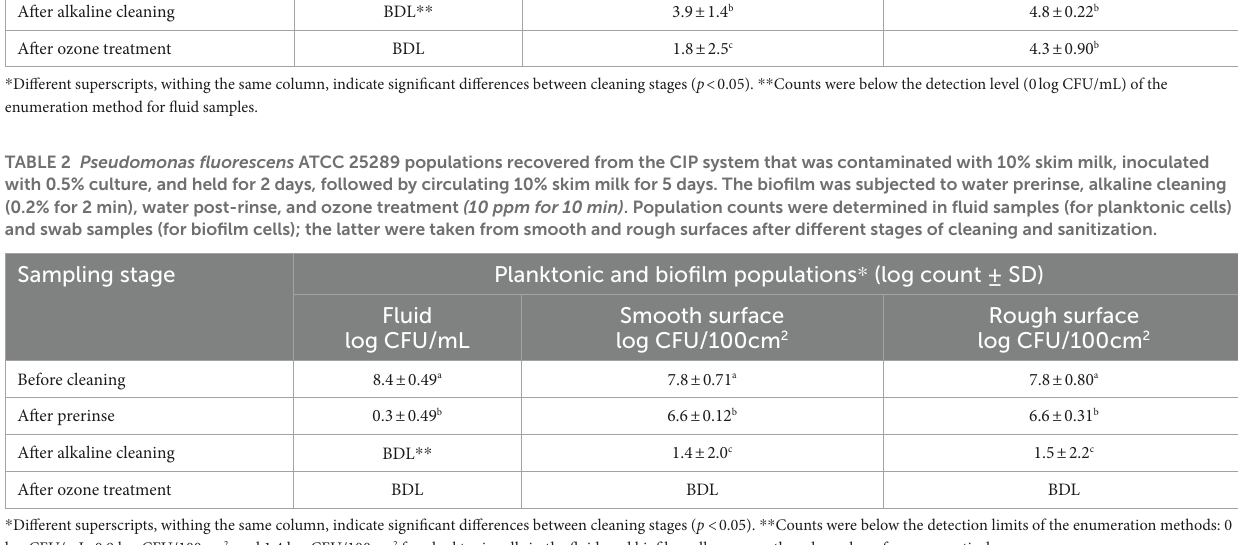
* Different superscripts, withing the same column, indicate significant differences between cleaning stages ( p < 0.05). ** Counts were below the detection limits of the enumeration methods: 0 log CFU/mL, 0.9 log CFU/100 cm 2 , and 1.4 log CFU/100 cm 2 for planktonic cells in the fluid, and biofilm cells on smooth and rough surfaces,